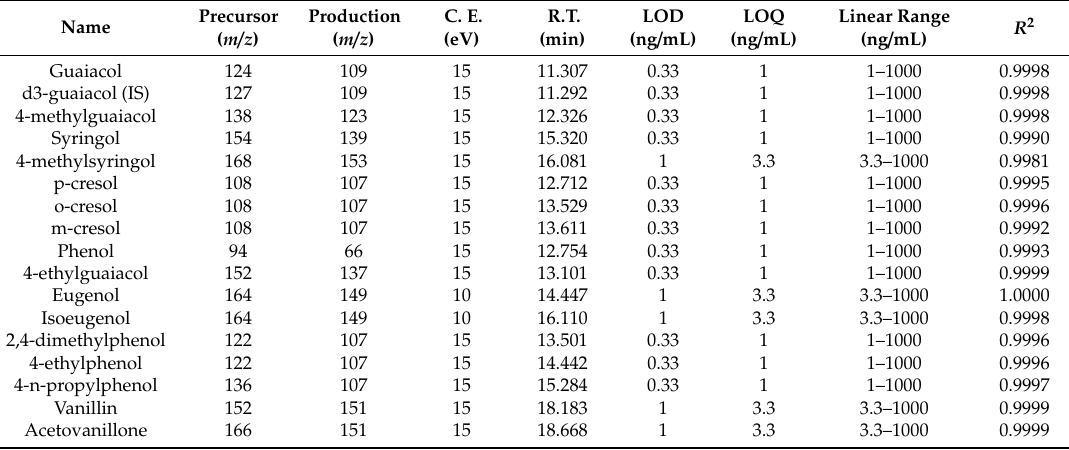
Table 1. MRM parameters, LOD, LOQ, and linear range for quantification of 16 phenolic compounds and the internal standard